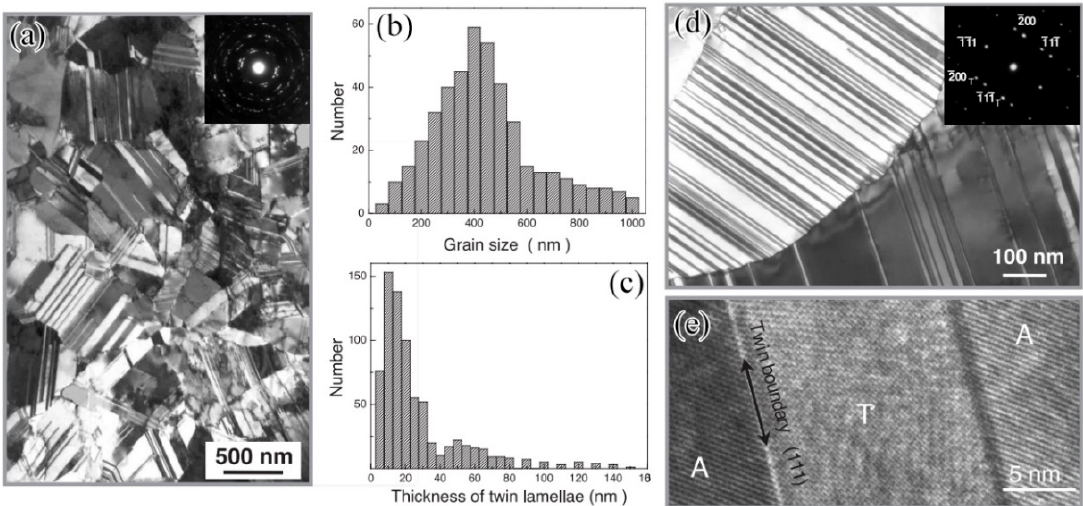
Figure 13. TEM observations of the typical microstructure in an as-deposited NT-Cu sample. Bright-field TEM image ( a ) and the electron diffraction pattern (inset) show roughly equiaxed submicrometer-sized grains with random orientations separated by high-angle GBs. The statistical distributions for grain size ( b ) and for thickness of the twin/matrix lamellae ( c ) (obtained from the many TEM images of the same sample). Electron diffraction patterns (inset in ( d )) indicate that the twins in each grain are parallel to each other in {111} planes ( d ), and high-resolution TEM images ( e ) show that the twins follow a sequence of ATATA, with twinning elements, for example, A: ( 1(cid:3364)11(cid:3364) )/[ 1(cid:3364)12 ] and T: ( 1(cid:3364)11 )/[ 11(cid:3364)2 ]. Adapted from [74].